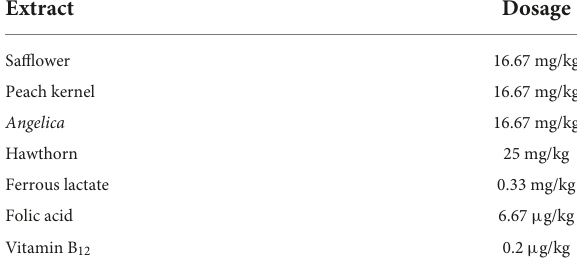
TABLE 1 Composition of the Chinese herbs